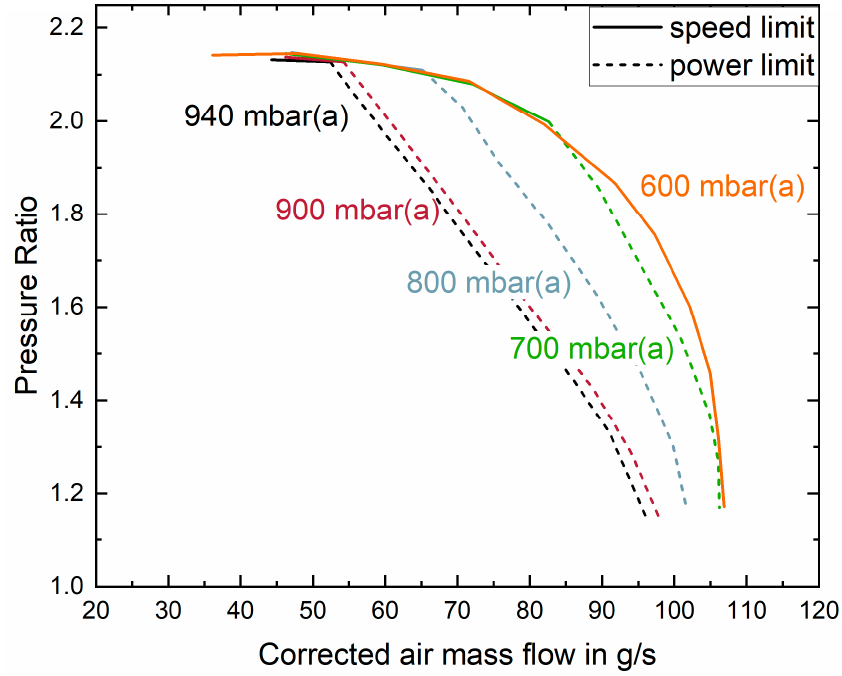
Figure 6. Corrected pressure ratios over corrected air mass flow for the measurements with the Fischer 150k compressor, for inlet pressures of 940, 900, 800, 700 and 600 mbar(a), corrected for 20 °C and 940 mbar(a). Dashed lines indicate the power limit.